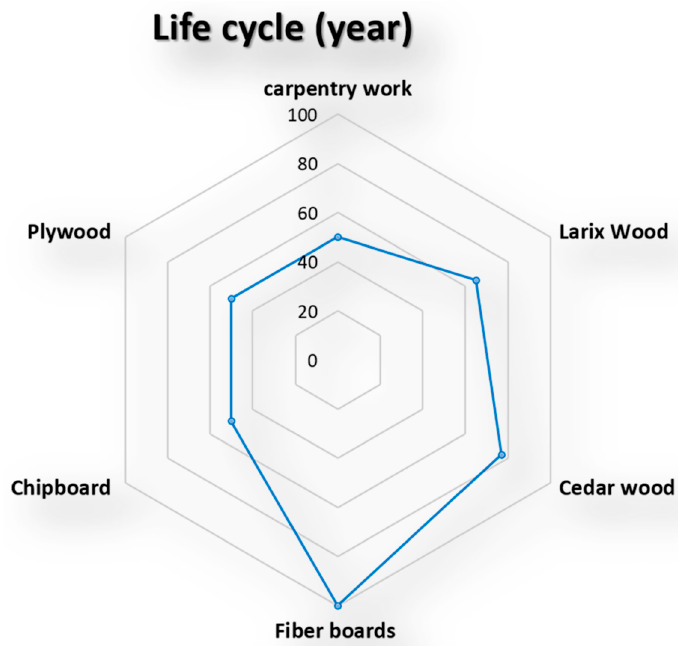
Figure 13. The life cycle façade wooden material [68–70].